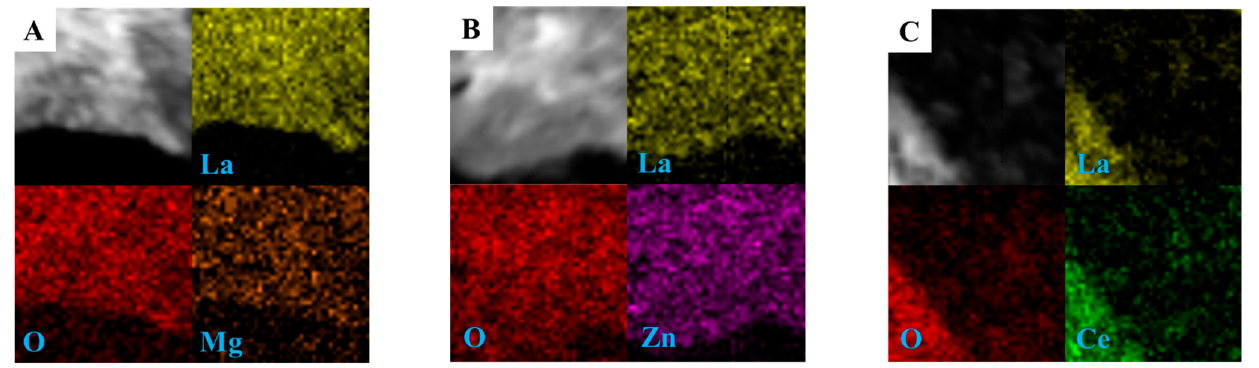
Figure 5. HR-STEM image and HAADF-STEM-EDX element-mapping analyses of La (yellow), O (red), Mg (orange), Zn (purple), Ce (green), ( A ) Mg-La 2 O 3 , ( B ) Zn-La 2 O 3 , ( C ) Ce-La 2 O 3 .